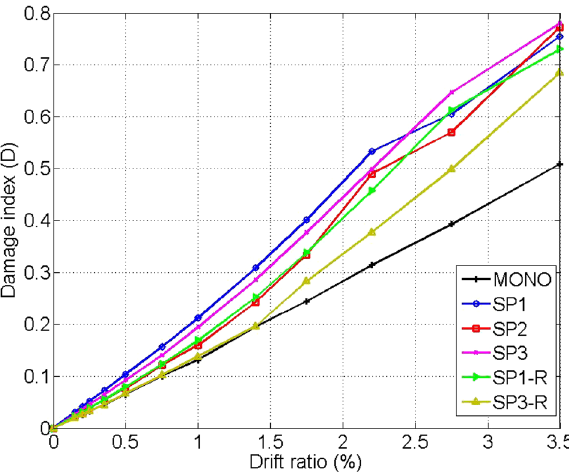
Fig. 25 Damage indices obtained for each test